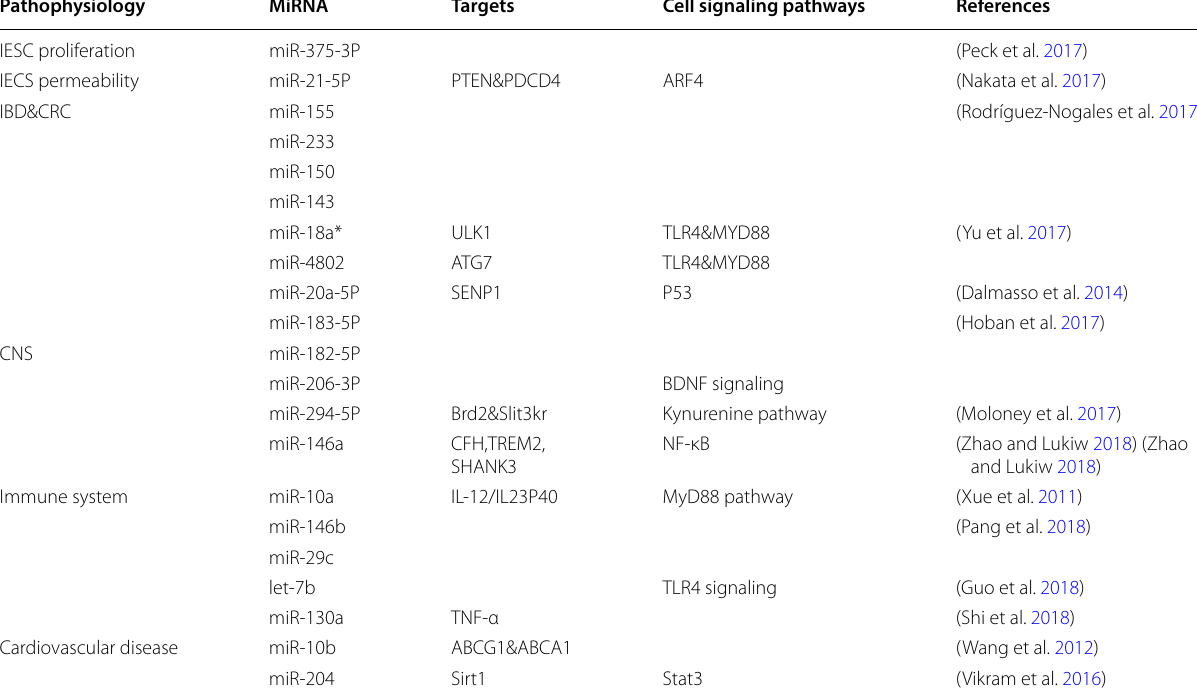
Table 1 Gut microbiota influences miRNAs in host pathophysiology